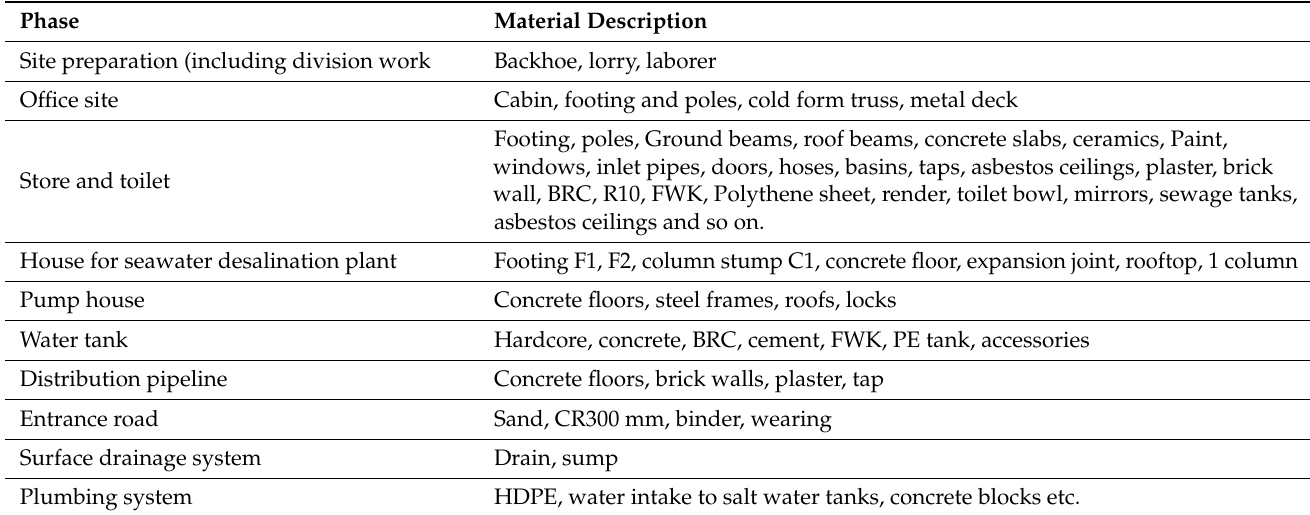
Table 2. The gross estimation of raw materials in the construction